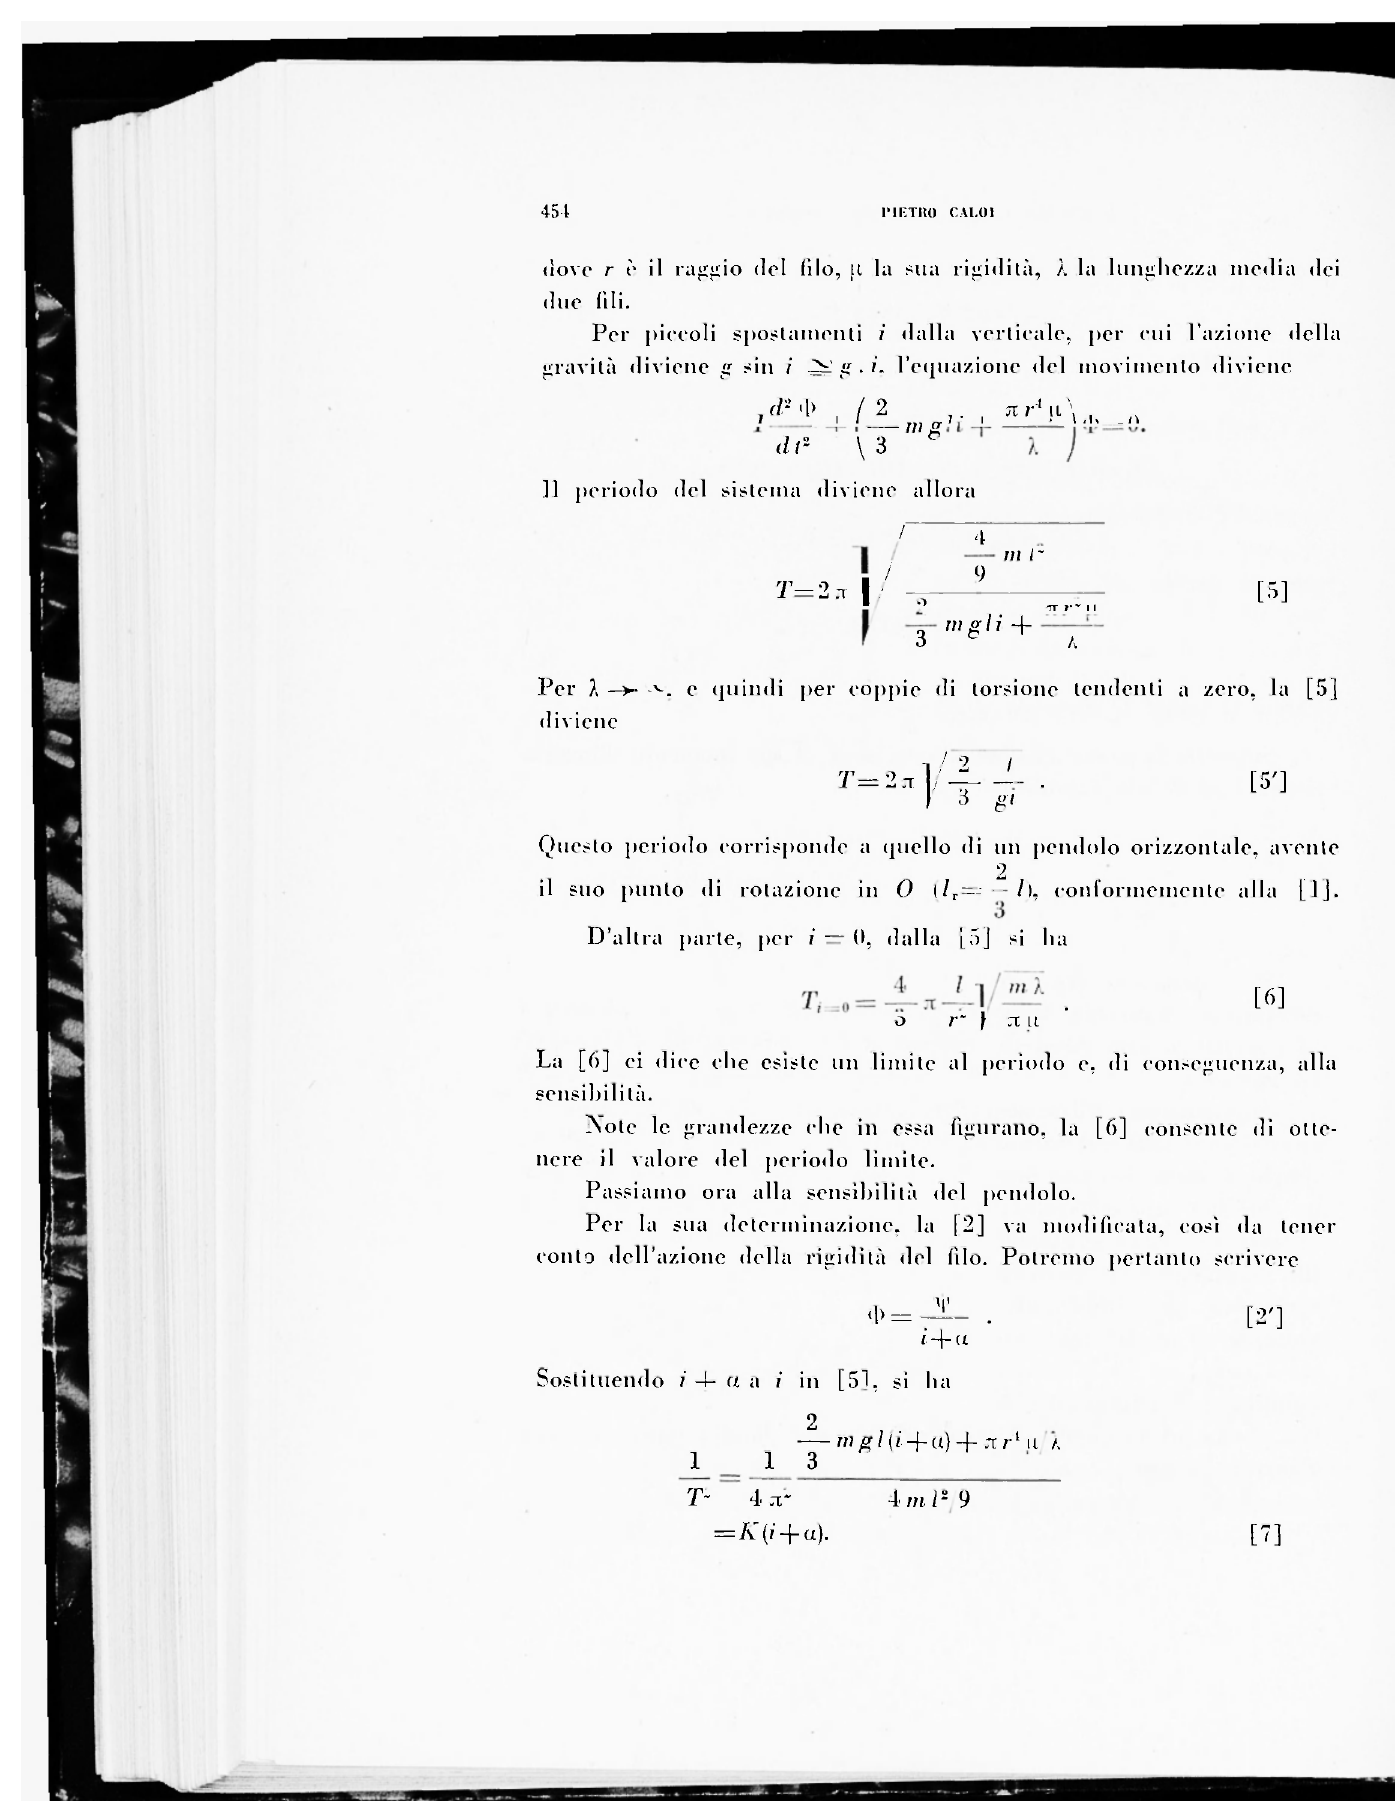
figurano, la [6] consente di otte- limile.